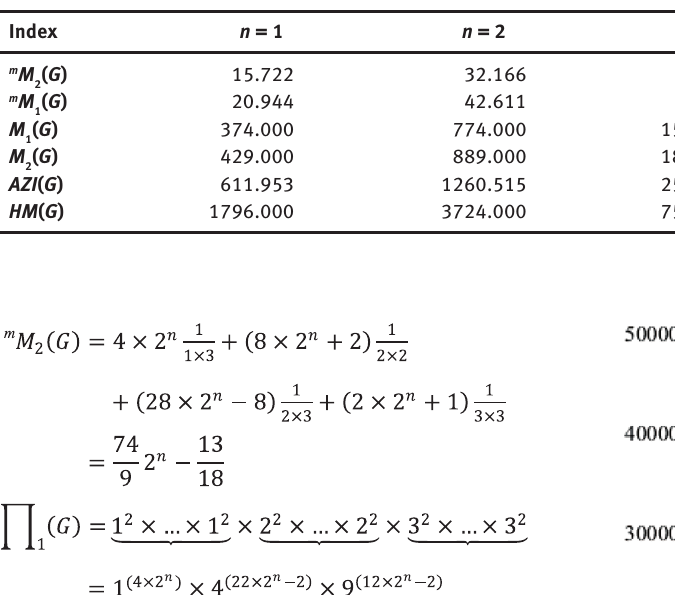
Table 4: Comparison table for Zagreb indices